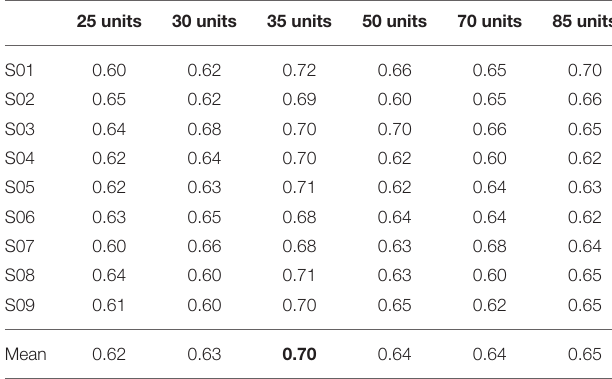
TABLE 2 | Comparison of classification accuracies based on different numbers of units in the first hidden layer for the nine subjects. 15 units